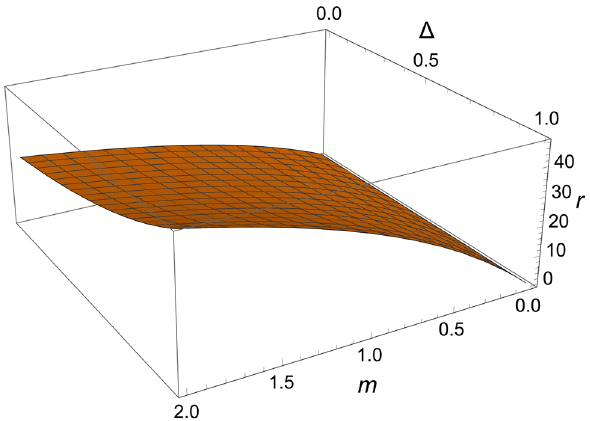
Fig. 2 3D plot of r versus the power-term m and Barrow parameter